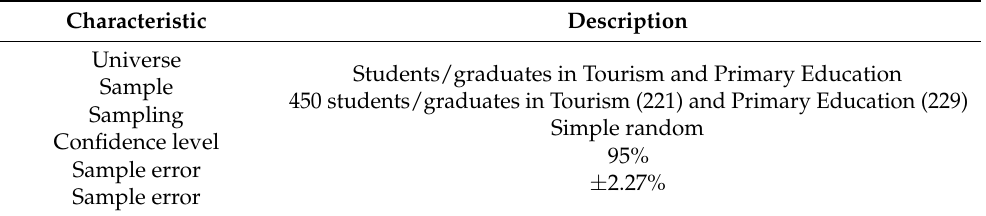
Table 4. Technical sheet of the survey designed for students/graduates in Primary Education or